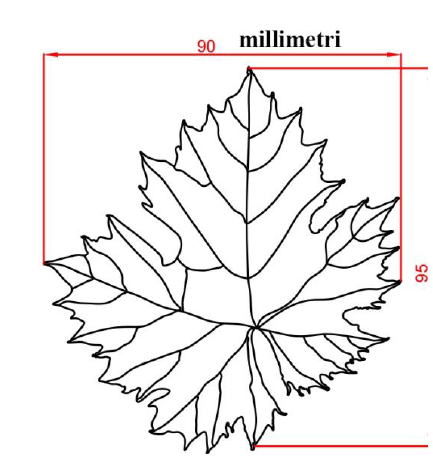
Figure 15. Projection on the plane (x,y) The texture in the (x,y) plane of the mesh allow one to obtain the graphic of the digital botanic atlas reported in figure 16, a); this can be compared with the drawing reproduced in the table of the traditional botanic atlas that is reproduced in Figure 16, b). In the first image the contours of the edge and of the structural nervations are notably more